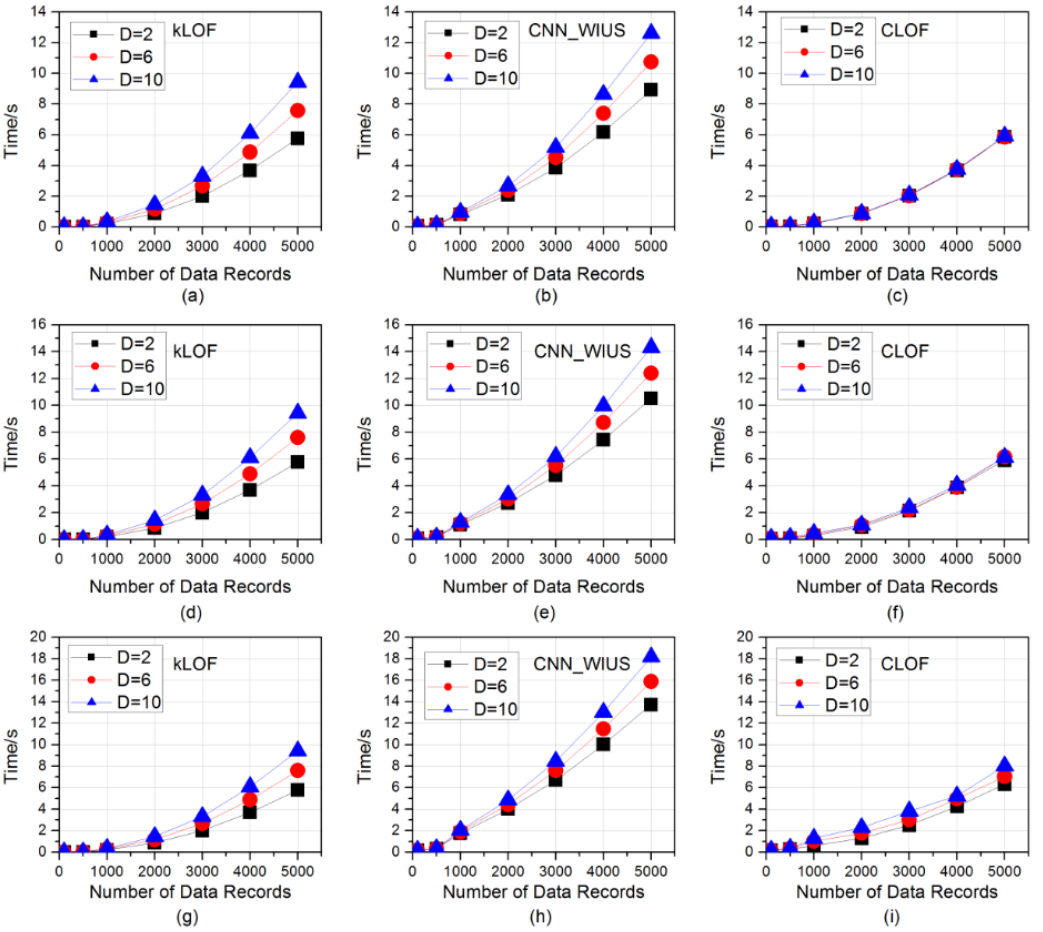
Figure 7. The time for updating the local outlier factor on standard Gaussian distribution synthetic datasets: ( a – c ) the time at k = 5 and D = 2, 6, 10 respectively; ( d – f ) the time at k = 10 and D = 2, 6, 10 respectively; ( g – i ) the time at k = 20 and D = 2, 6, 10 respectively.